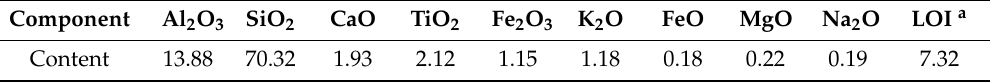
Table 4. Composition of the residue (wt.%).